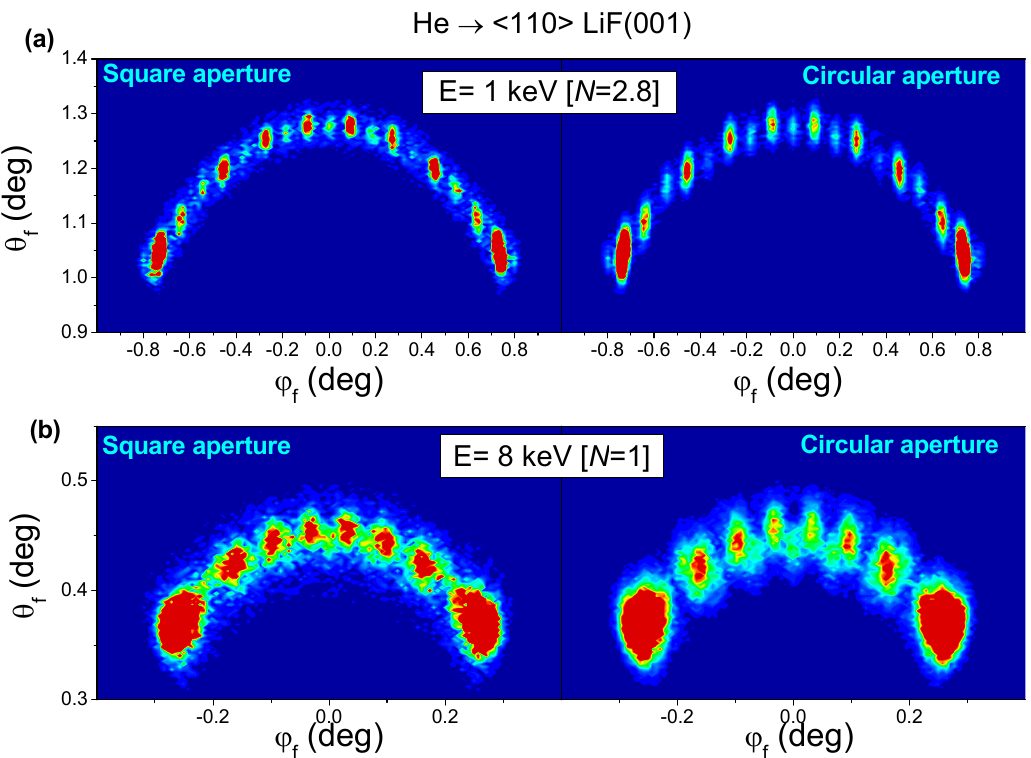
Figure 5. (Color online) Two-dimensional distribution, as a function of θ f and ϕ f , for He atoms impinging along (cid:104) 110 (cid:105) with E ⊥ = 0.5 eV and total energy: ( a ) E = 1 keV and ( b ) E = 8 keV. Square and circular collimating openings, with d = 0.2 mm, are considered in the left and right panels,